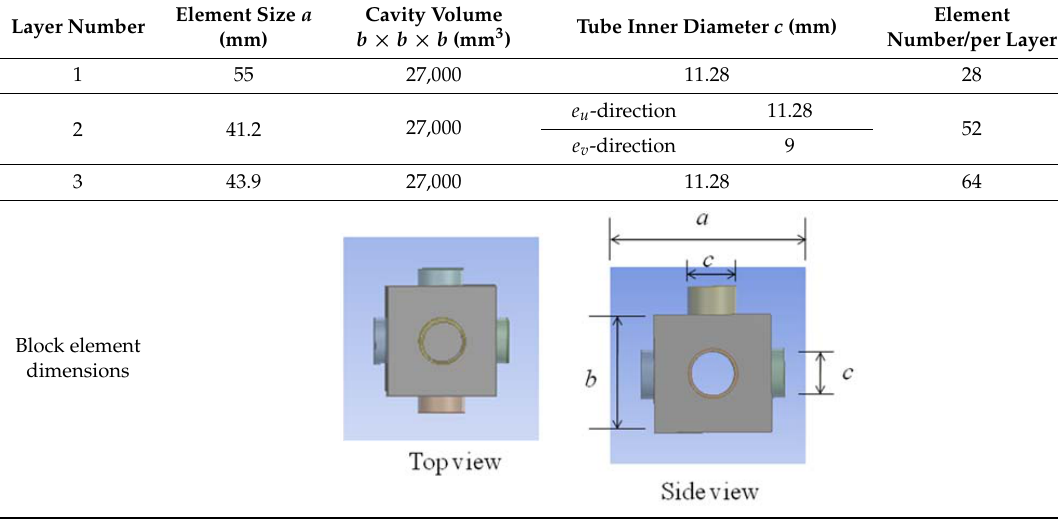
Figure 8. The interior details of the meta ‐ composite material structure. The block elements include cavities and tubes arranged as circular elements in three layers. The inset on the left shows the details of block elements with rectangular cavities and tubes sliced by a surface in the u e – v e plane. The right inset presents details of the block elements sliced by a surface in the u e – w e plane. They exhibit the details of the cloak shell layered structures inside the cloaked region. The combination of cavity and tubes of the block element provides the acoustic impedance value b Z in specific u e , v e , and w e directions, respectively.